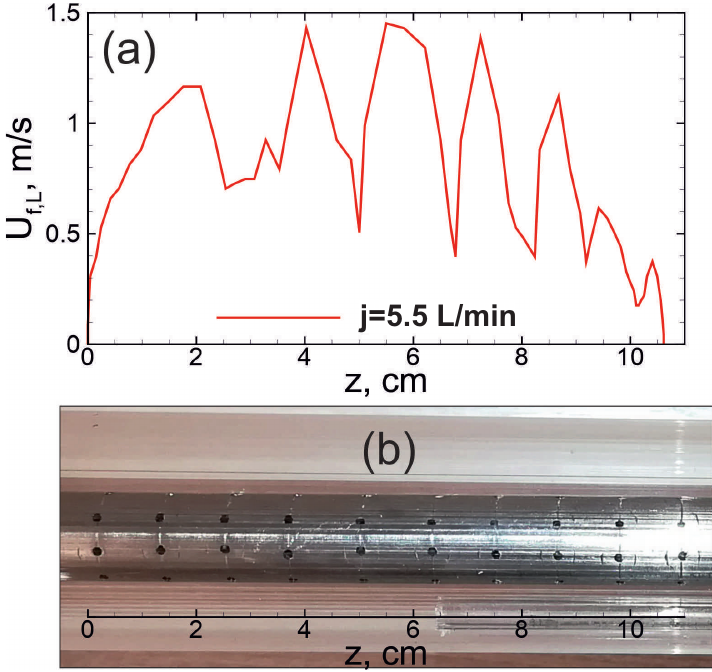
Figure 5. ( a ) Experimentally obtained history of the flame speed along the channel length at flow rate of 5.5 L/min and ( b ) corresponding position of the holes in the wall of inner